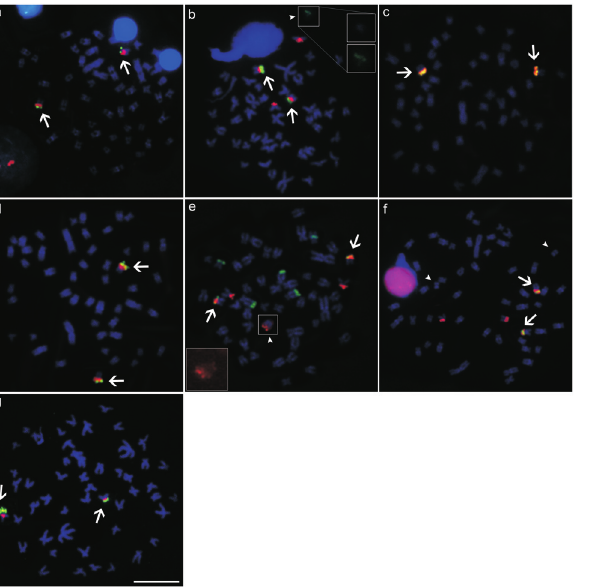
Figure 6 - Metaphases mapped by double-FISH with 5S rDNA (red) and U2 snDNA (green) probes in: (a) M . cosmops ; (b) M . forestii ; (c) M . nigromarginata ; (d) Moenkhausia sp. n.; (e) M . oligolepis (Xapuri River); (f) M . oligolepis (Corredeira Stream), and (g) M . oligolepis (Sangue River). Chromosome synteny between markers is indicated by the arrows, while the B chromosomes are shown by the arrowheads. Scale bar = 10 (cid:2)